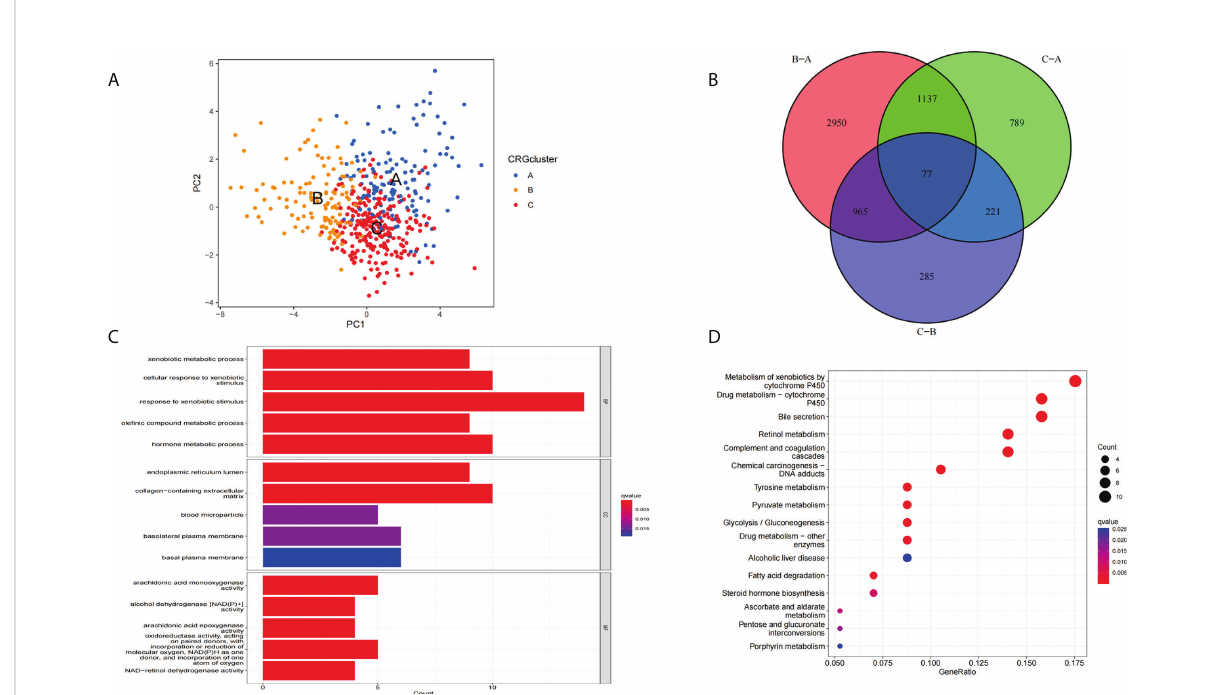
FIGURE 5 Functional enrichment analysis of DECRGs. (A) Principal component analysis of three clusters. (B) The Venn diagram shows the intersection of DECRGs (C) Analysis of BP, CC, and MF terms of GO enrichment demonstrated the possible function of the DECRGs. (D) Kyoto Encyclopedia of Genes and Genomes (KEGG) pathway enrichment analysis revealed the possible